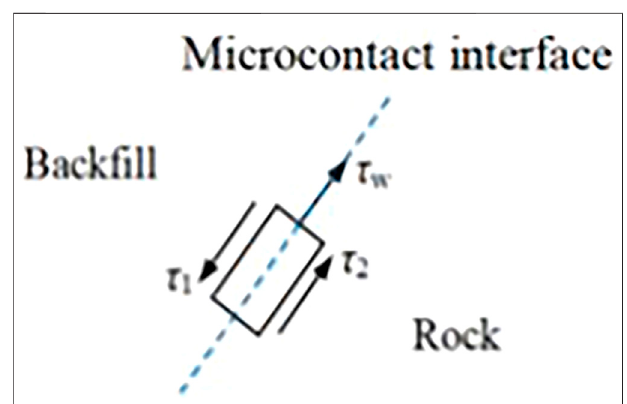
FIGURE 3 | Force schematic diagram of interface under a vertical loading.